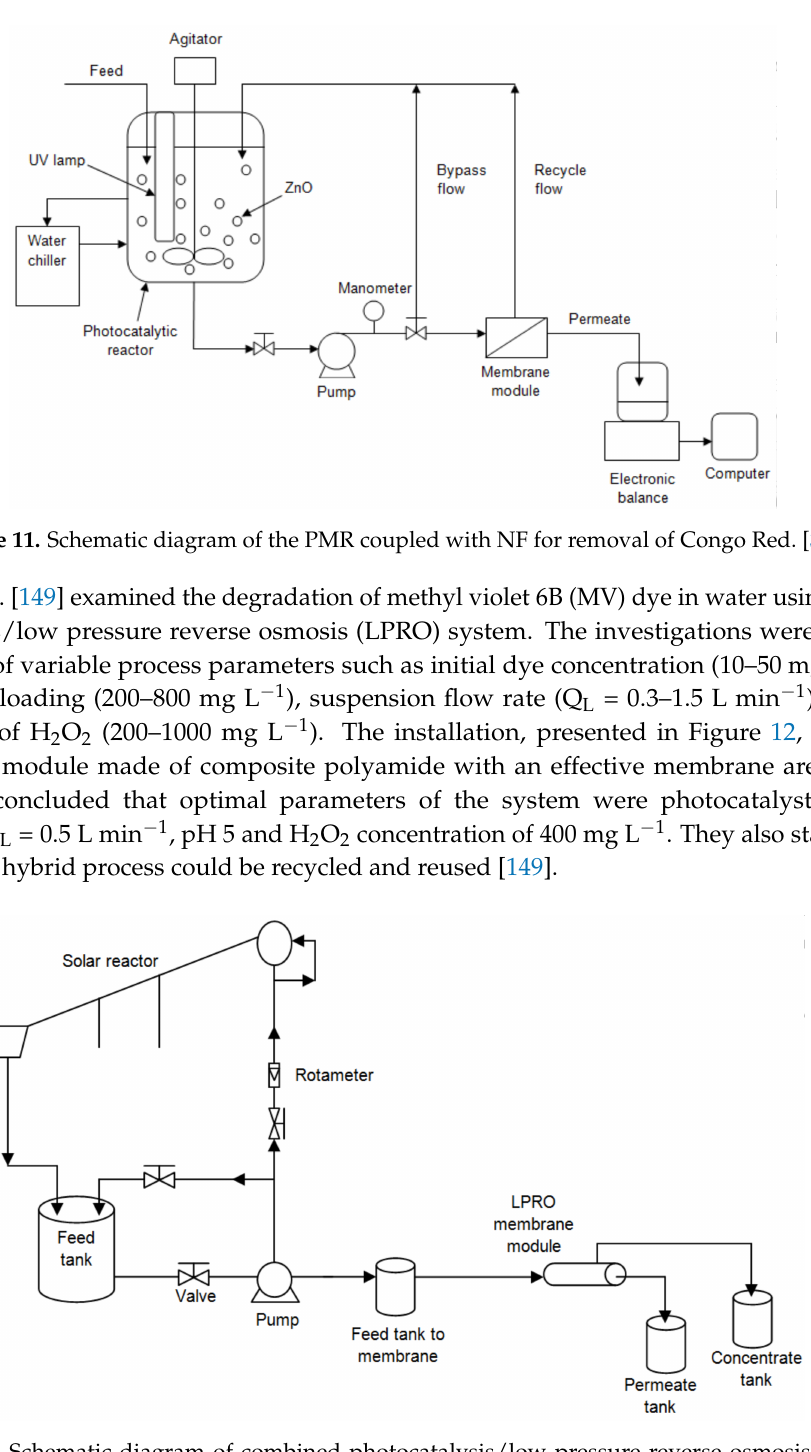
Figure 12. Schematic diagram of combined photocatalysis/low pressure reverse osmosis (LPRO) system to methyl violet dye removal